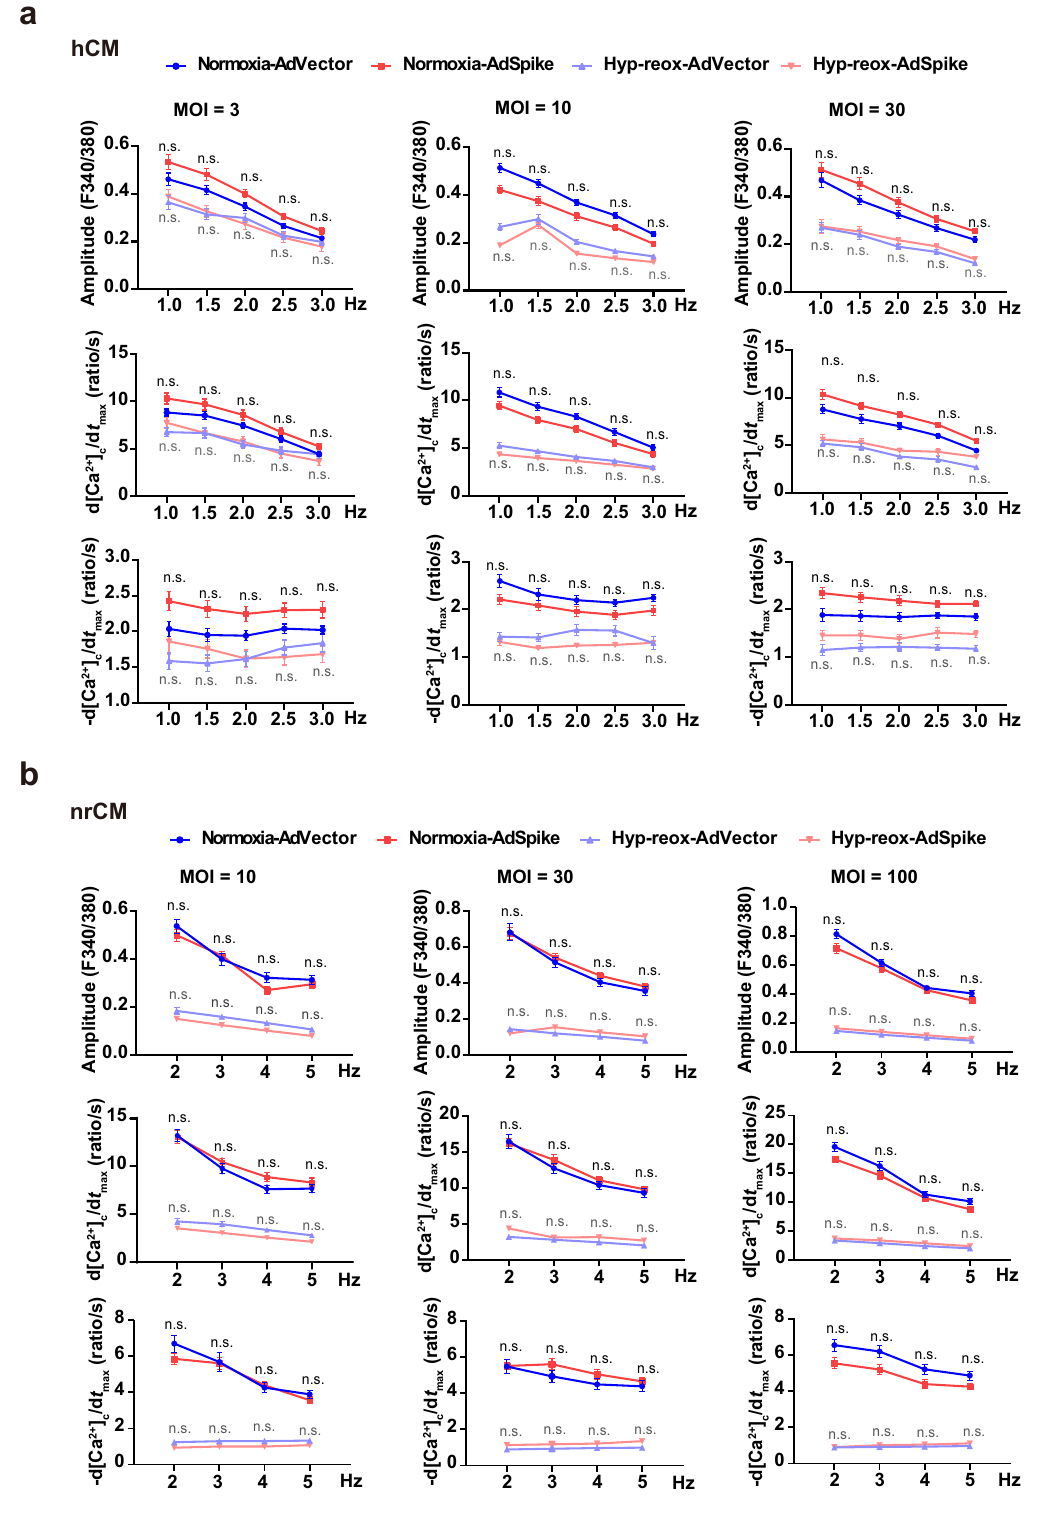
Fig. 3 AdSpike has little effect on calcium handling properties of cultured cardiomyocytes subjecting to electrical fi eld stimulation with or without hyp-reox injury. Averaged parameters of calcium transient of hCMs ( a ) or neonatal rat cardiomyocytes (nrCM, b ) infected by AdVector or AdSpike with different frequency of electrical fi eld stimulation. n = 15 – 30 for each group. Statistical signi fi cance was assessed using 2-way ANOVA with Turkey post- test. Data are presented as mean ± SEM; n.s., not signi fi cant as compared with the corresponding AdVector control, in which the black color indicates comparison within the normoxia group, and gray color indicates comparison within the hyp-reox